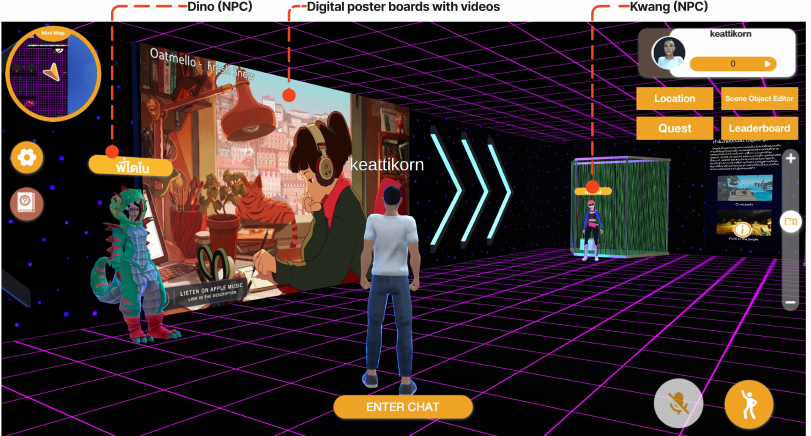
Figure 9. Digital game department (DG) interior with an example of a digital poster board with video on the left, close to the NPC. The overhead text displayed on the NPCs are Dino and Kwang, on the left and the right,